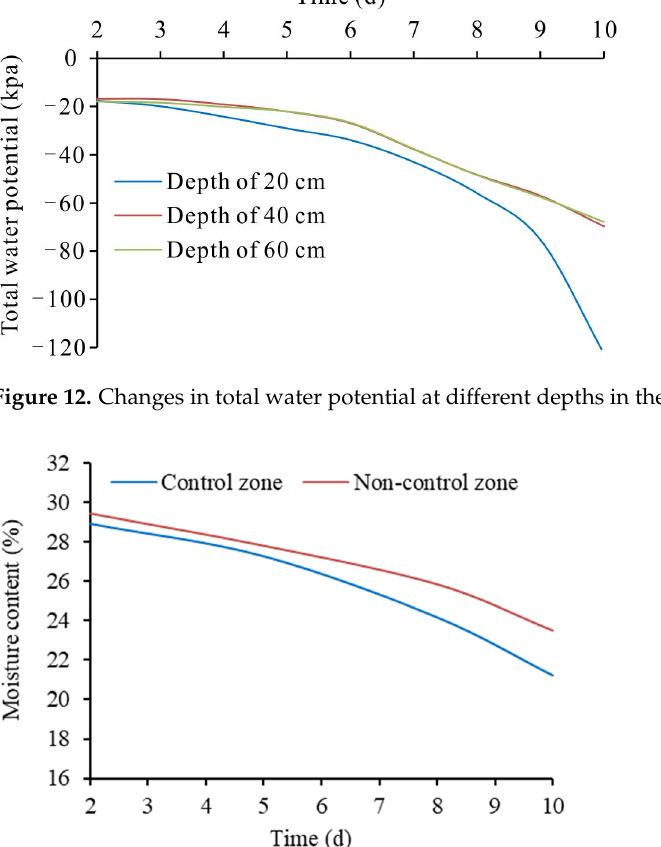
Figure 13. Changes in the moisture content in control and non-control zones.